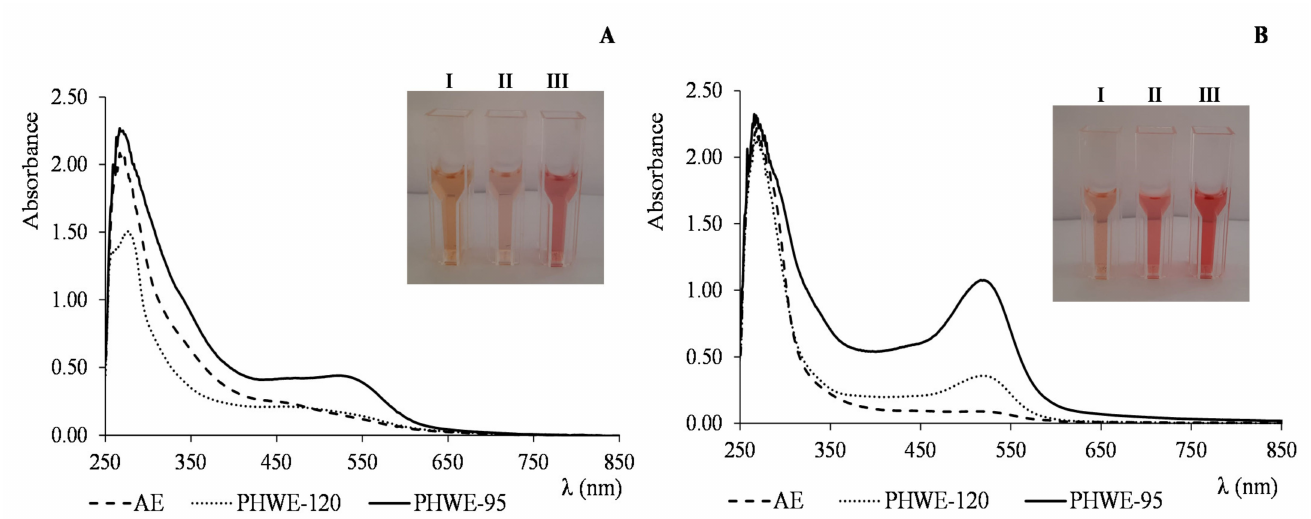
Figure 1. UV-Visible spectra of polysaccharide–polyphenol conjugates fractions ( A ) before acidic hydrolysis and ( B ) after acidic hydrolysis. I, II and III cells correspond to AE, PHWE-120 and PHWE-95 extracts,